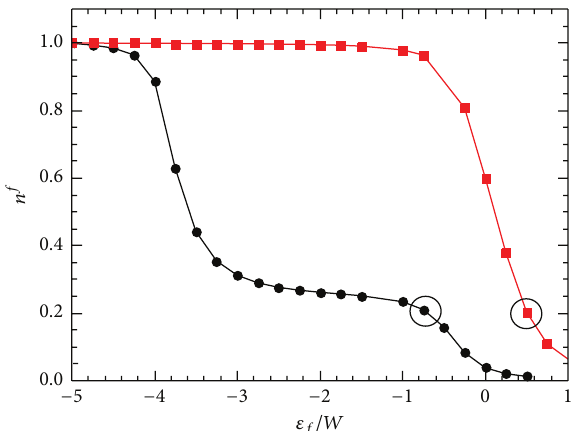
Figure3:The 𝑓 -leveloccupancyasafunctionof 𝜀 𝑓 for 𝐿 = 80 , 𝑈 𝑐𝑓 = /𝑊 = 4 (bullet); furthermore 𝑈 0 (red square) and 𝑈 𝑐𝑓 𝑉/𝑊 = 0.2 . The circled data points are used in the comparison in Figure 4. The lines are guides to the eye.